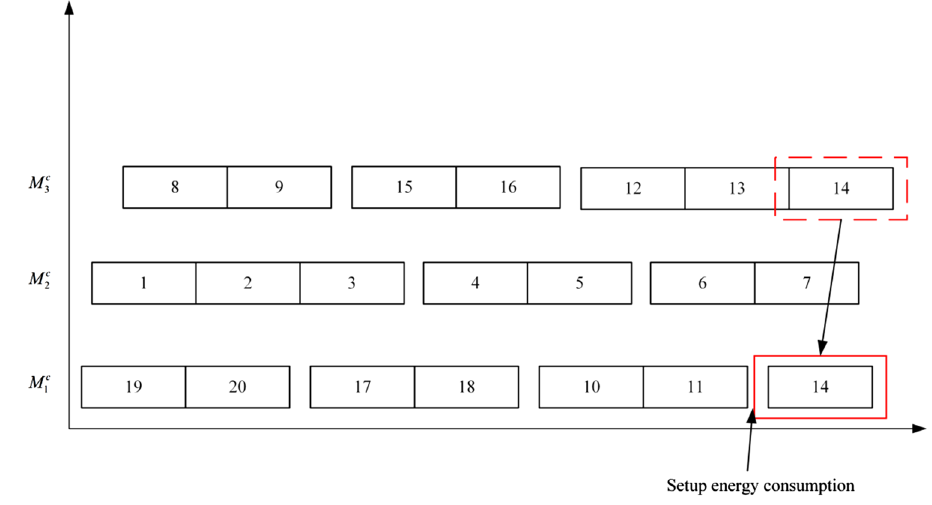
Fig. 7 The adjusted job process- ing sequence in stage